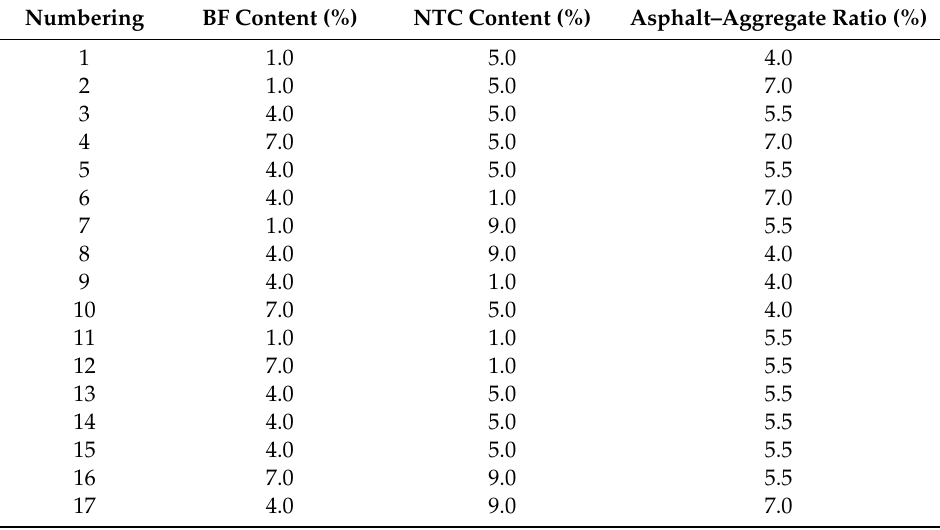
Table 7. Optimization of test